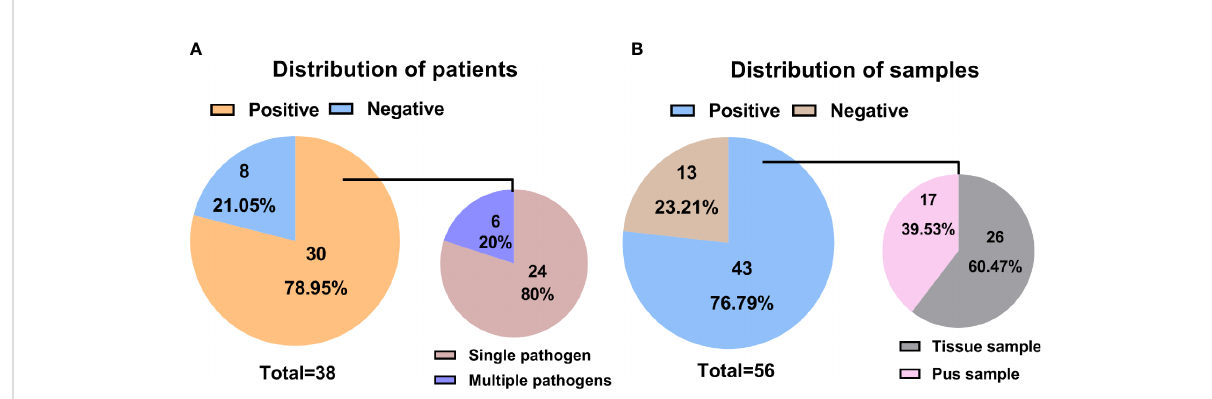
FIGURE 1 Statistical data on mNGS information in different patients and samples. (A) Distributions of positive and negative results in patients with spinal infection; (B) Distributions of positive and negative results in samples associated with a spinal infection.